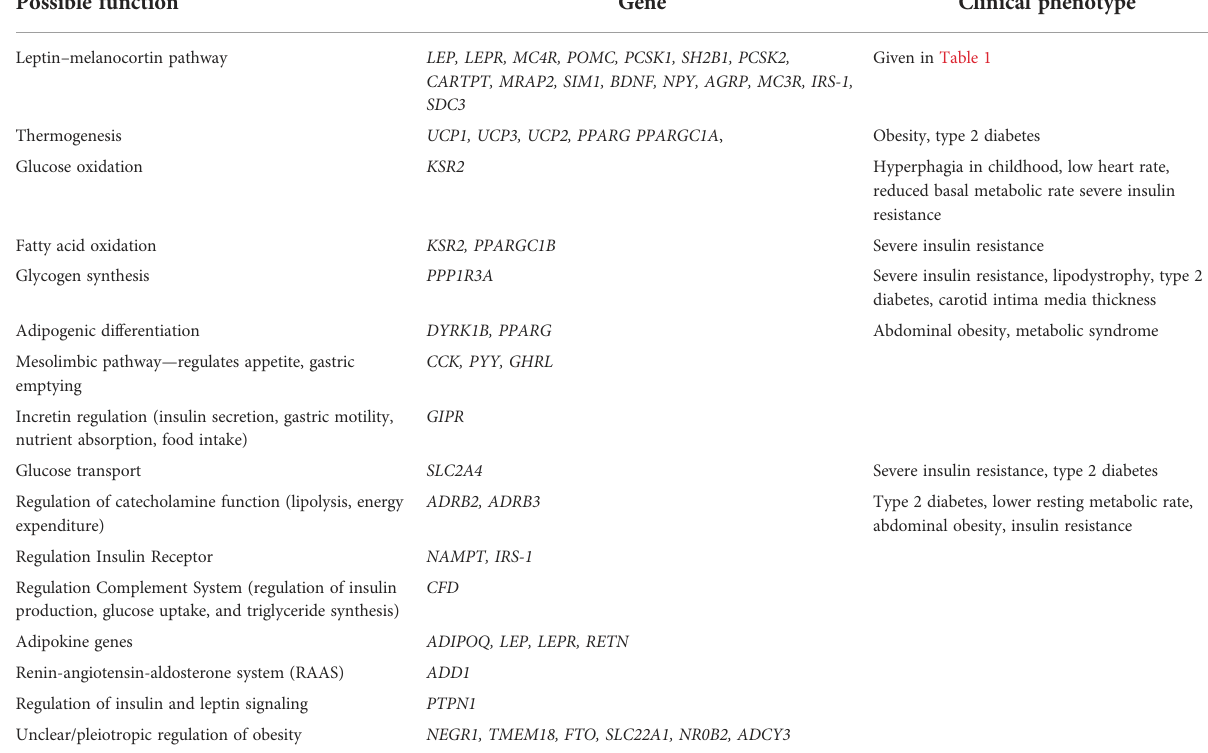
TABLE 2 The possible function and clinical phenotype of the obesity-related genes. Possible